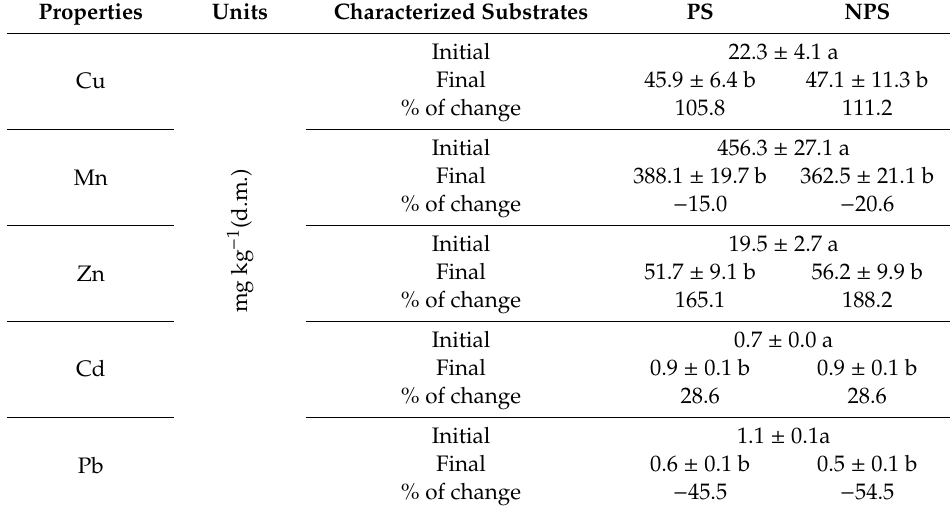
Table 4. Microelement contents in plant waste and the obtained